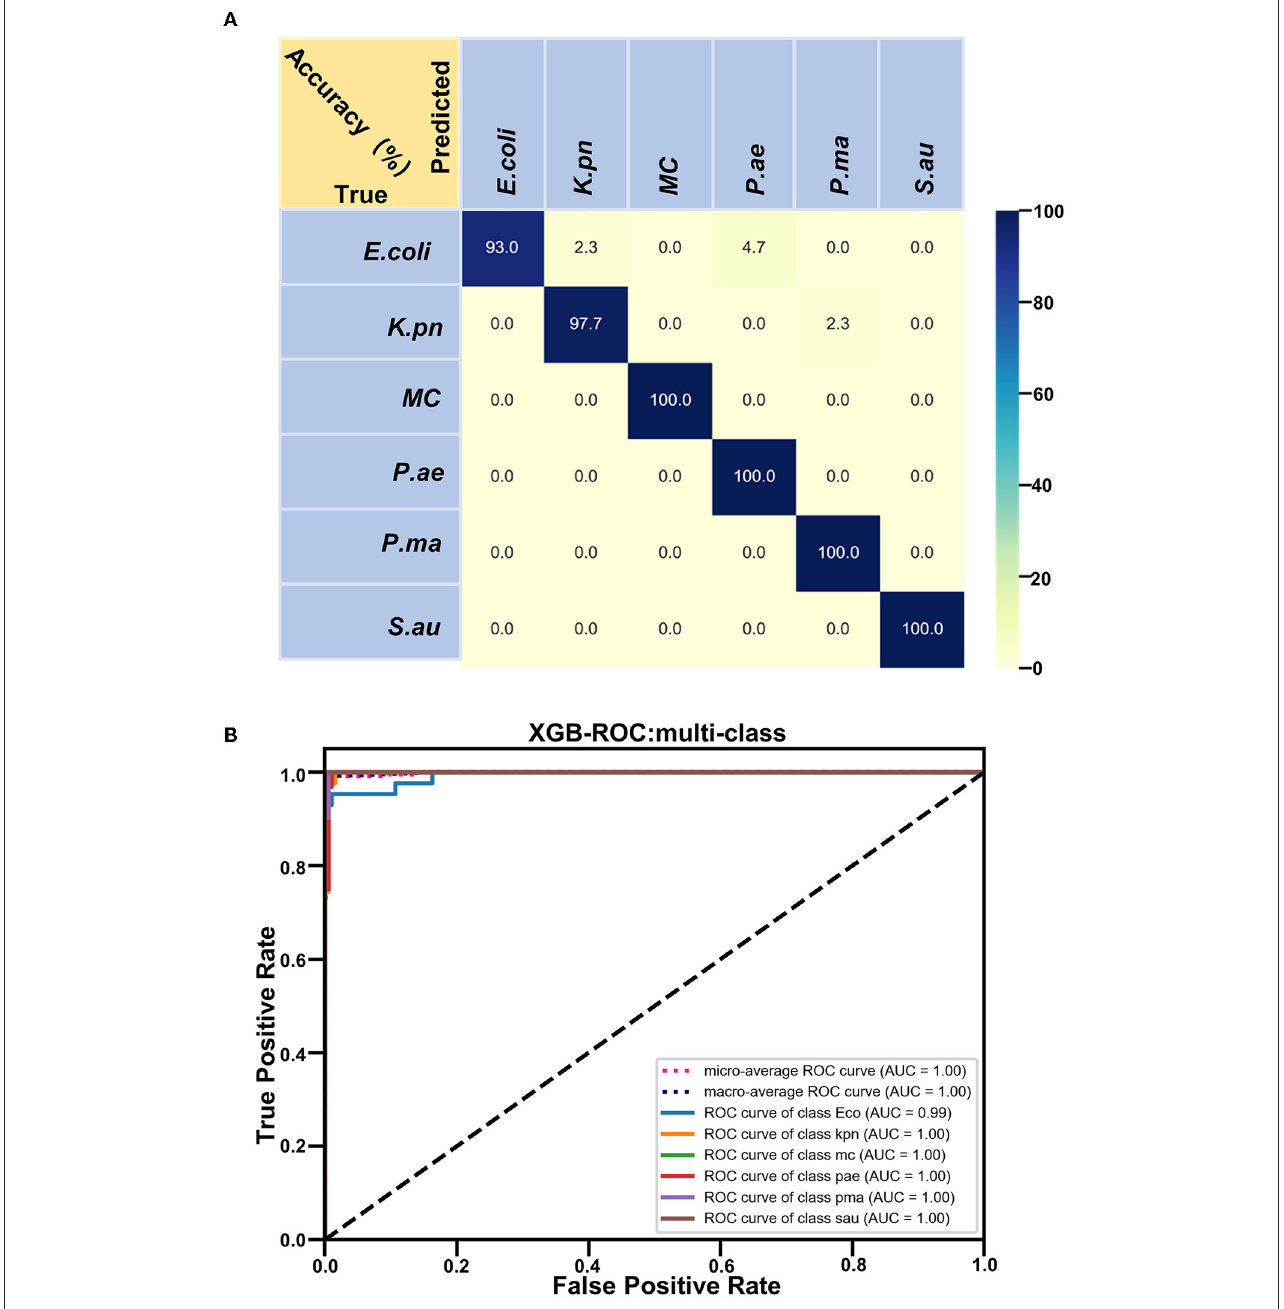
FIGURE4 (A) XGB modeling and prediction results. (B) XGB analysis of ROC